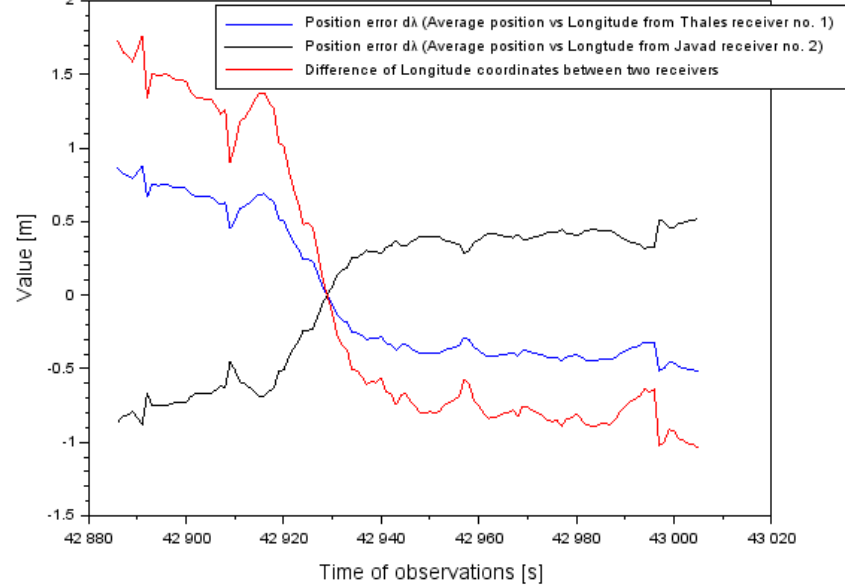
Figure 13. The position error of aircraft coordinates λ in the flight test in Che ł m.